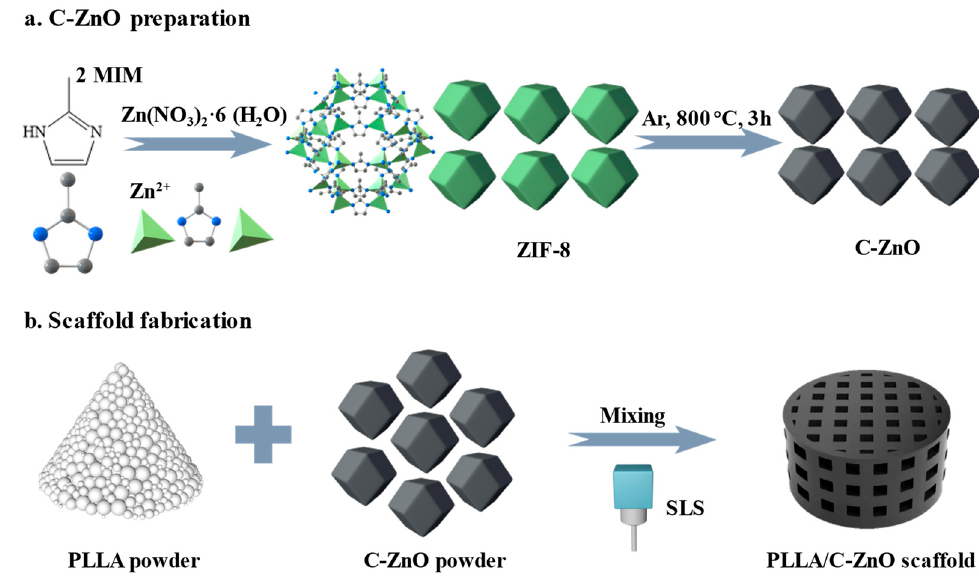
Figure 1. Schematic illustration.